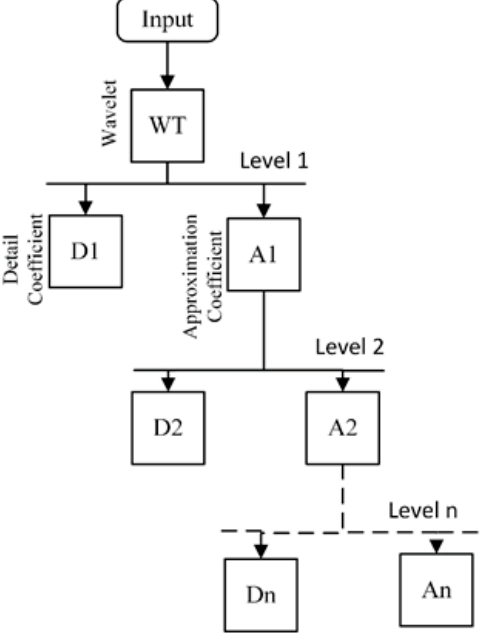
Figure 1. Level-wise decomposition with wavelet transform.